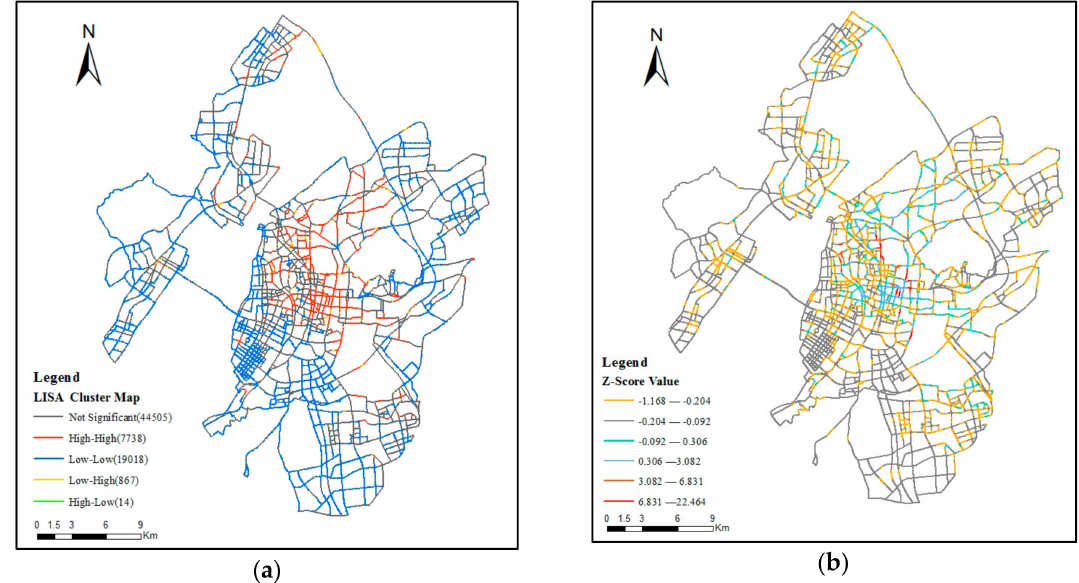
Figure 13. Result of NKDE-ILINCS method: ( a ) local clustering patterns; and ( b ) z value distribution.